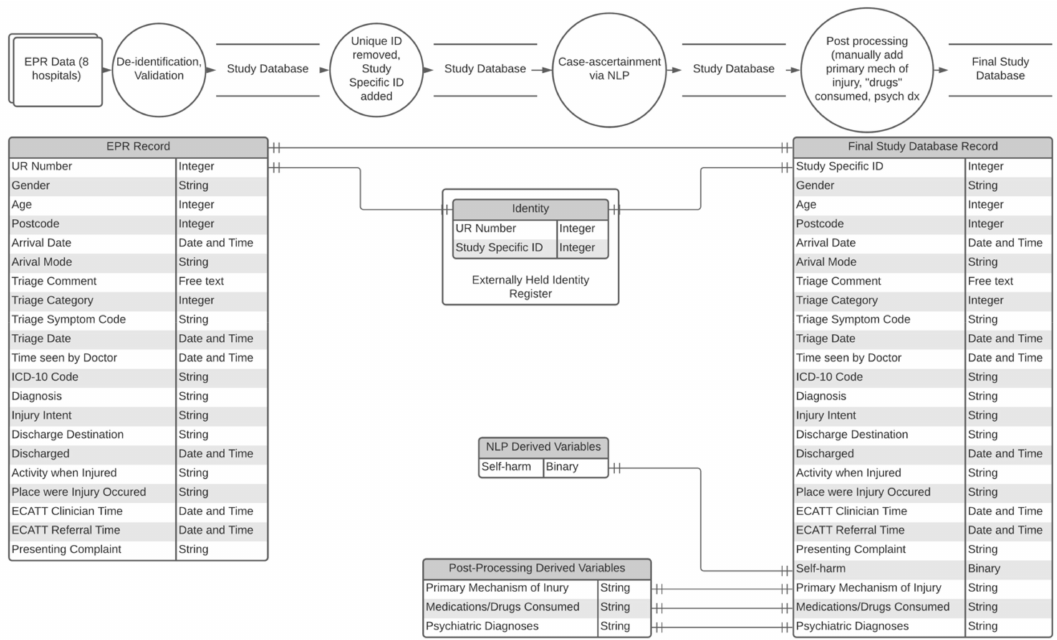
Figure 4. Data flow diagram of the Self-Harm Monitoring System for Victoria. Notes: dx: diagnosis; ECATT: Enhanced Crisis Assessment Treatment Team; EPR: electronic patient record; ICD-10: International Classification of Disease, version 10; ID: identity; NLP: natural language processing; UR: unit